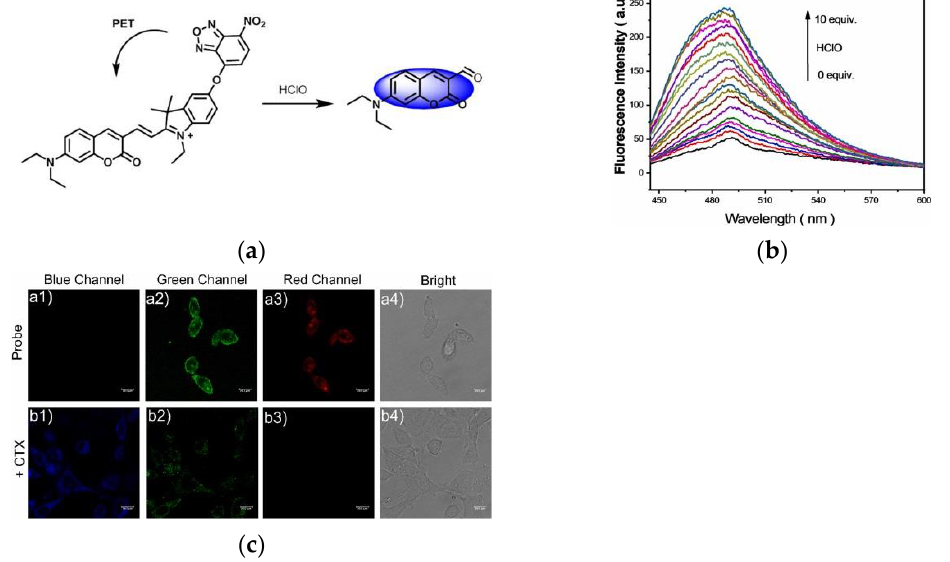
Figure 34. ( a ) Mechanism of the RSS-HClO activation by HClO; ( b ) Fluorescence intensity of RSS-HClO; ( c ) Fluorescence images in CTX-treated KYSE-30 cells. Reproduced with permission from [153]. Copyright 2021 Elsevier B.V.